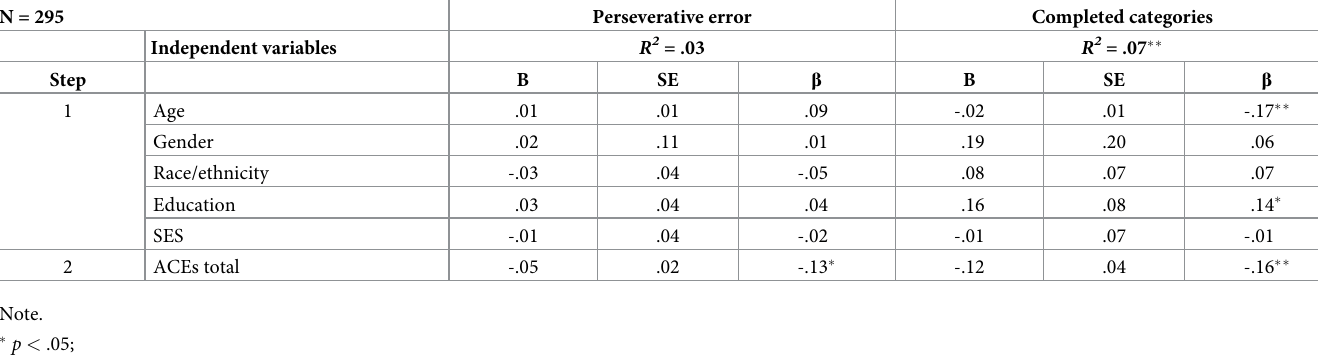
Table 4. Hierarchical regression predicting performance on WCST in Study